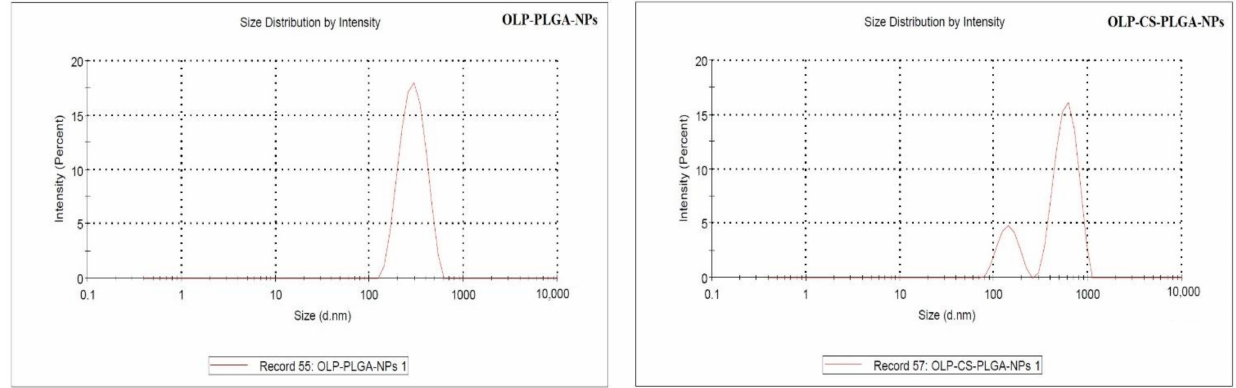
Figure 1. Mean hydrodynamic particle size of “OLP-loaded PLGA NPs and OLP-loaded CS-PLGA NPs” measured by the DLS technique.